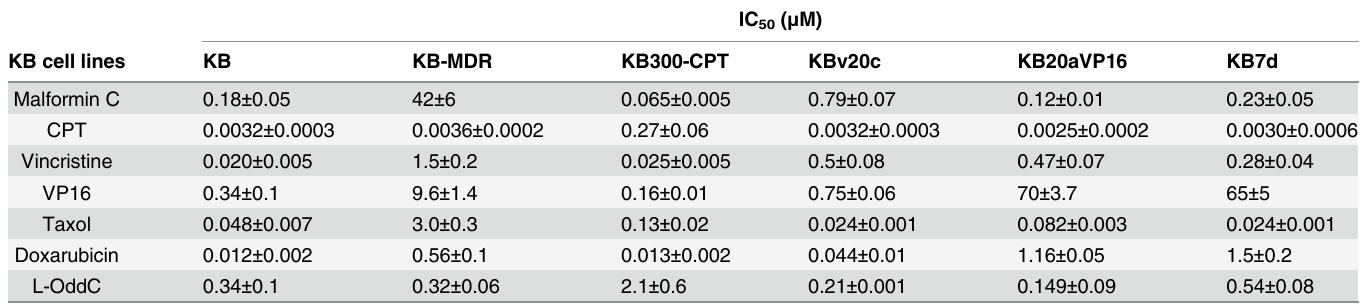
Table 2. Growth inhibition of KB and its drug-resistant cells by Malformin C and anti-cancer drugs.